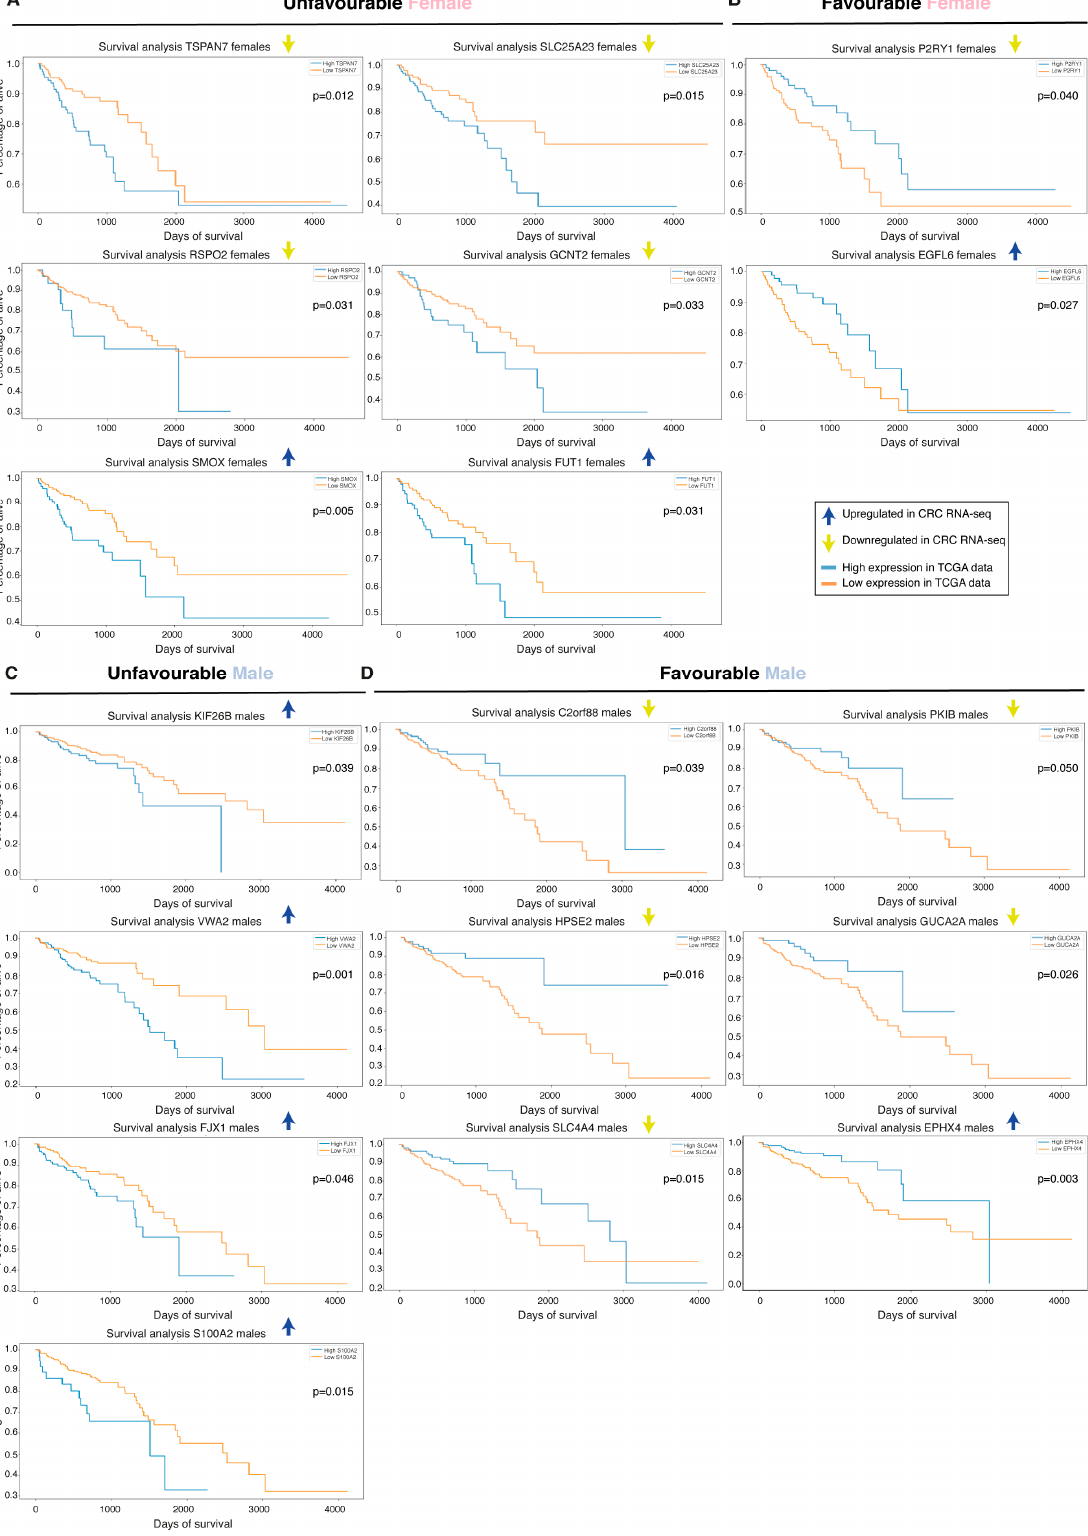
Figure 6. Sex-specific prognostic value of the biomarkers. Survival analysis on the features not belonging to top 20 for female and male TCGA data and for the biomarker identified in our Swedish mixed cohort that showed an unfavorable ( A ) and favorable ( B ) prognostic value in female TCGA data. ( C ) Biomarkers that showed an unfavorable ( C ) and favorable ( D ) prognostic value in male TCGA data.